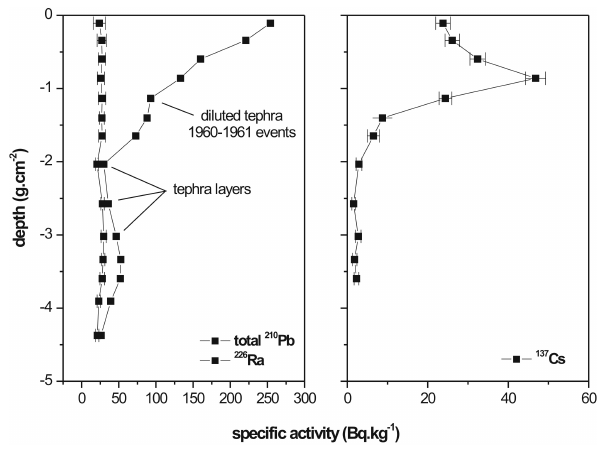
Fig. 3. Lake Tonˇcek sedimentary sequence. Specific activity pro- files of 137 Cs, 210 Pb, and 226 Ra (in secular equilibrium with sup- ported 210 Pb).